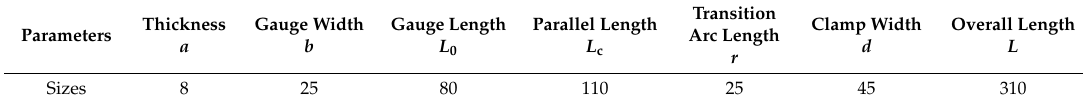
Table 3. Sizes of the coupon (unit: mm).